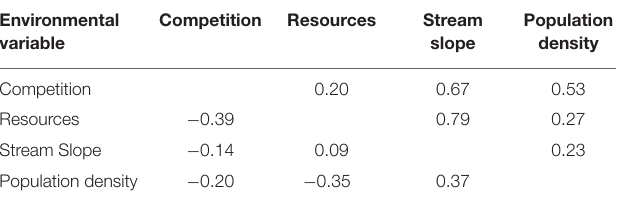
TABLE 3 | Pairwise correlation coefficients with P -values of the four putative selective